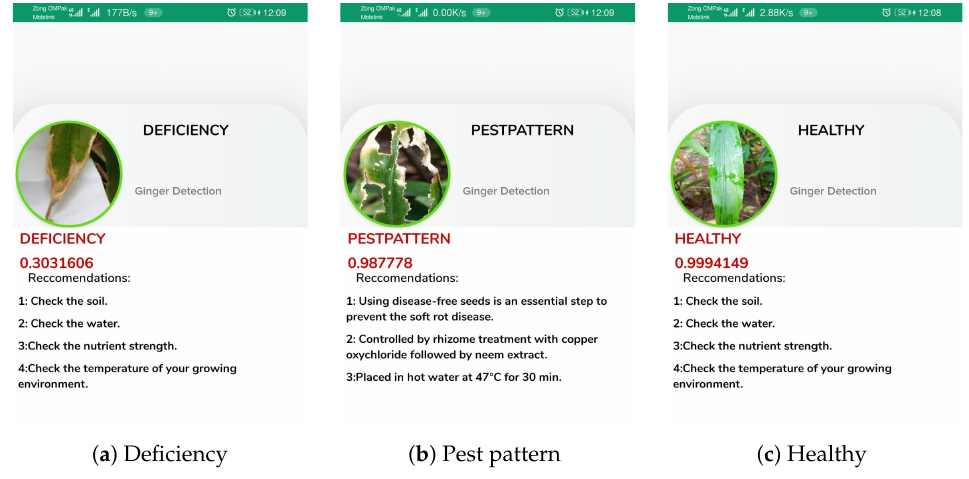
Figure 14. Example 2: Android application results.